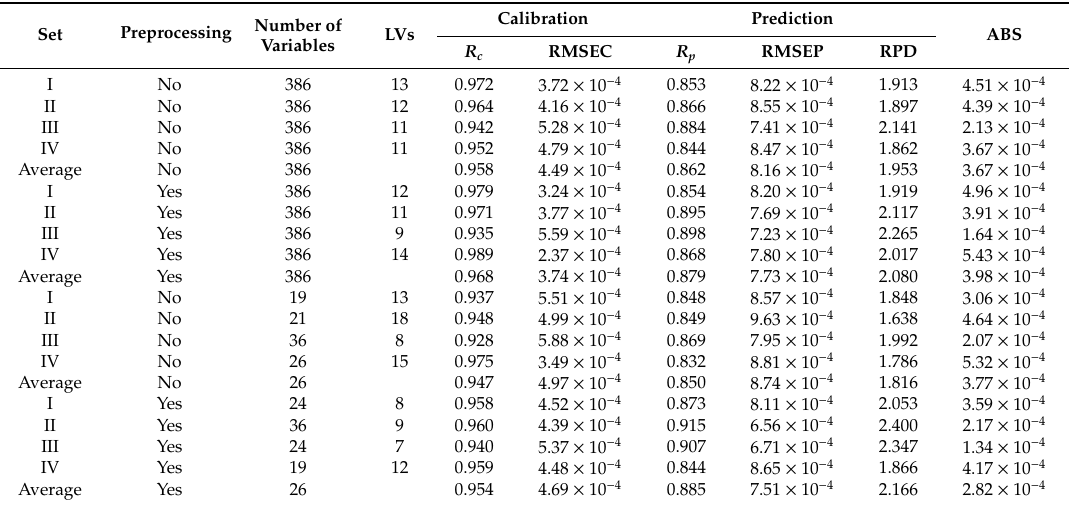
Table 1. PLSR model predictions for pesticide residue detection using LIBS data both with all variables (upper half) and with only optimal variables (lower